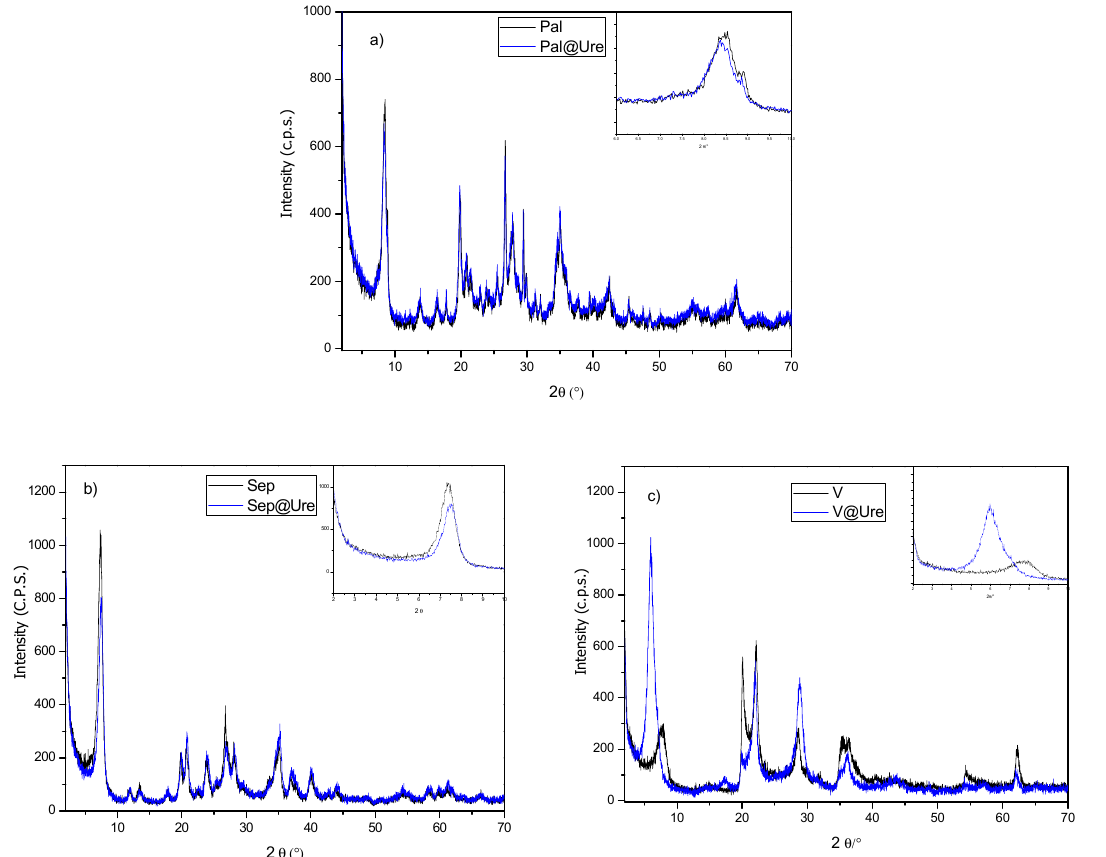
Figure 1. X-ray diffractograms of the clay minerals before and after encapsulation. a ) Palygorskite (Pal) and Palygorskite with urea (Pal@Ure), b ) sepiolite (Sep) and sepiolite with urea (Sep@Ure), c ) Veegum ® (V) and Veegum ® with urea (V@Ure).